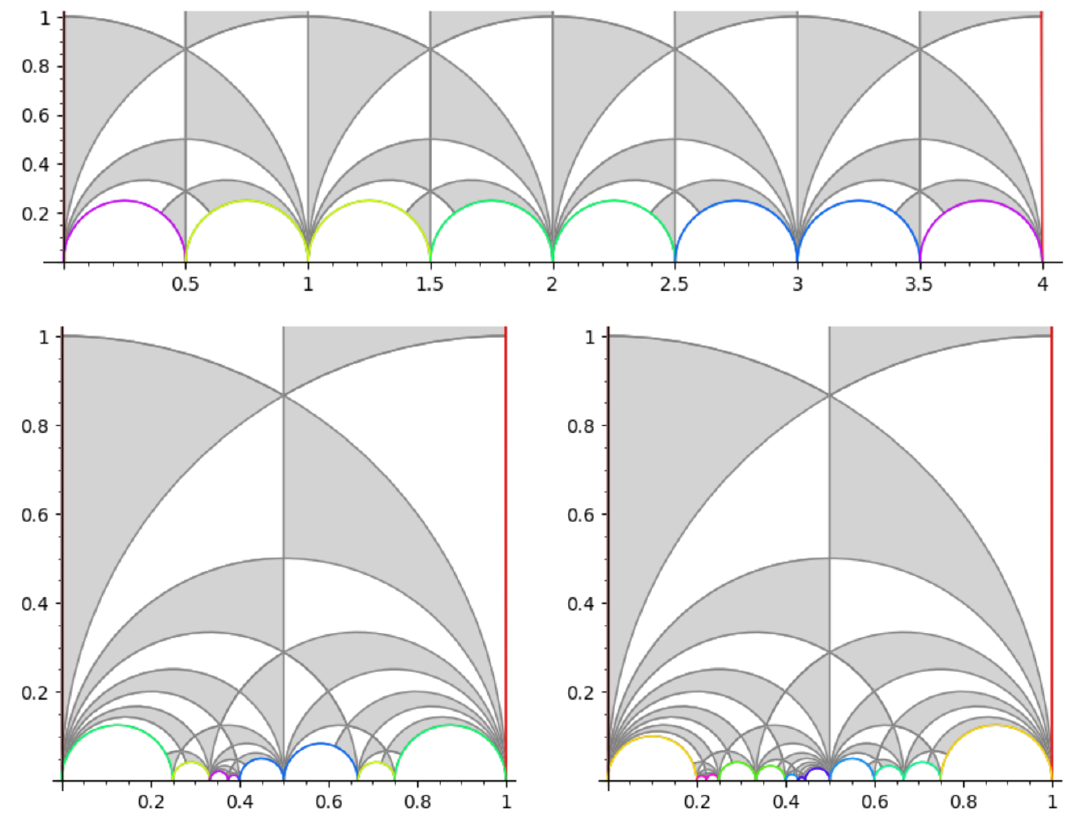
Figure 6 . Triangulations of X (4), X 1 (8) and X 1 (9). Colors highlight identi(cid:12)ed lines, allowing to read o(cid:11) the cusp points and their